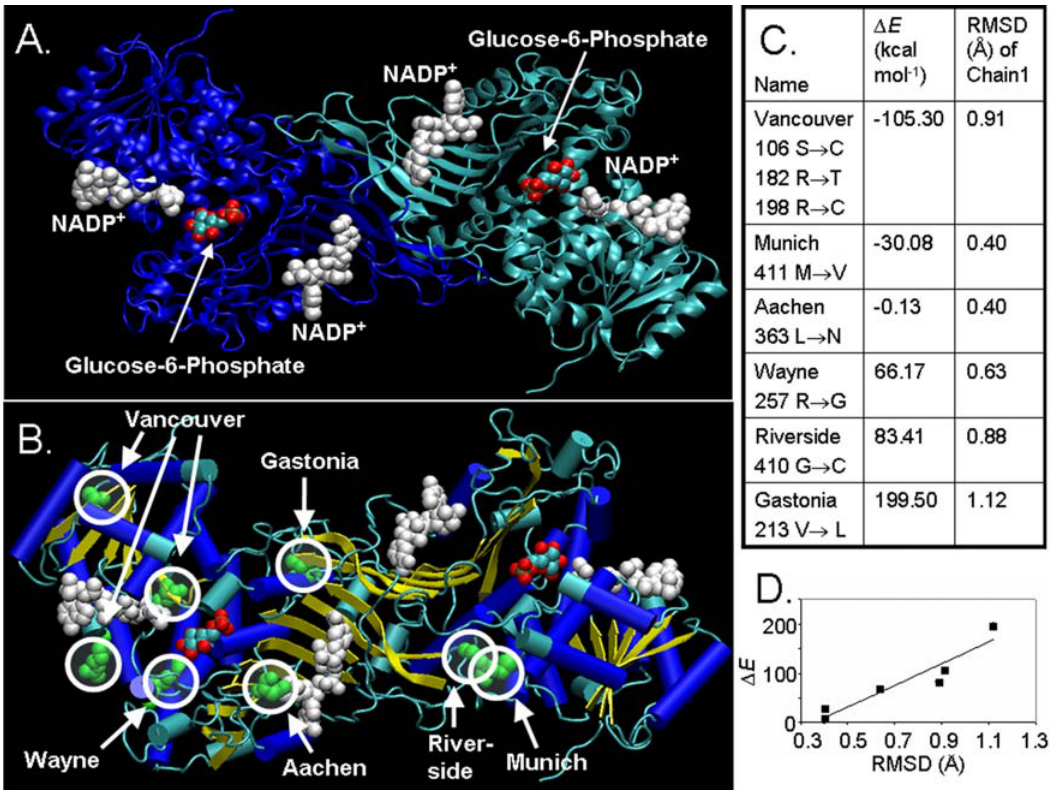
Figure 1. Molecular modeling of G6PD variants of German ancestry . (A) Wild-type structure of G6PD, with NADP + entries from 2BH9 and G6P entries from 2BHL (shown as van der Waals representation). The two chains are shown in green and blue. (B) The locations of the six mutations is shown as green Van der Waal radii, highlighted by red circles. Beta sheets are shown in yellow color, while alpha helices are shown in blue color. (C and D) The root mean square is taken over one monomer, comparing the optimized structure of the mutant and that of the wild type. Figures were created with VMD software [28].